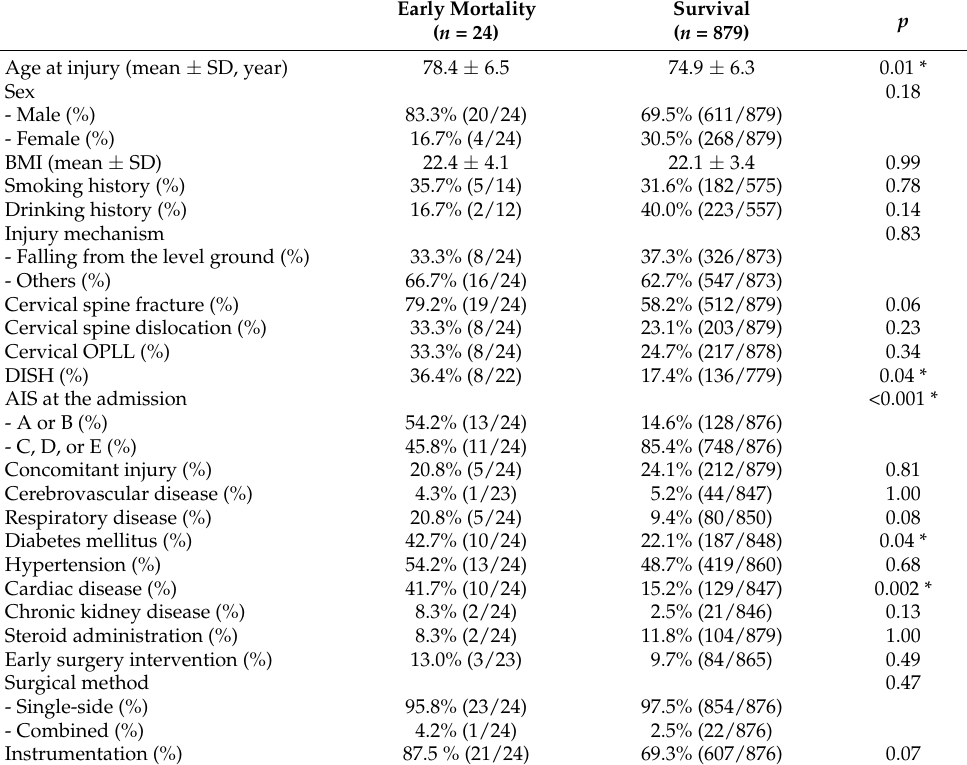
Table 4. Comparison between the survival and early mortality groups in the surgical treatment